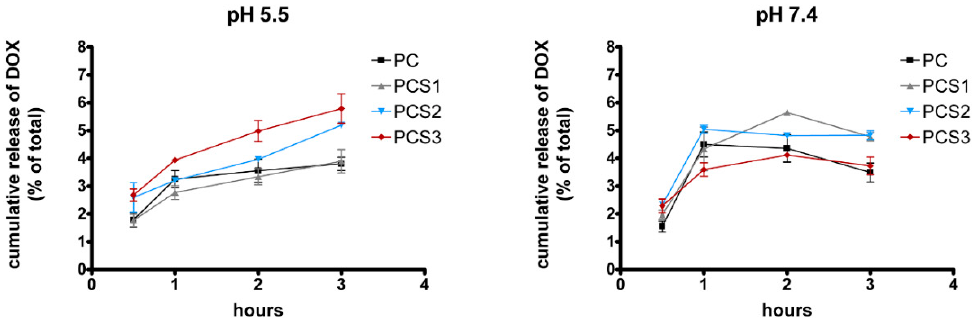
Figure 7. Doxorubicin (DOX) release from PC, PCS1, PCS2, and PCS3 systems at pH 5.5 and 7.4. Values are calculated based on DOX standard curve (0–400 µg/mL).